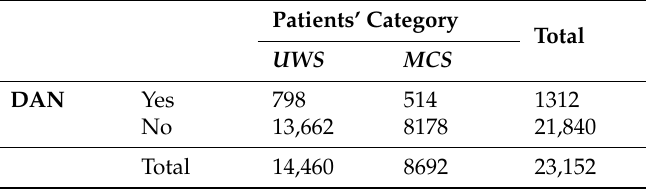
Table 7. Distribution of activation peaks within the dorsal-attentional network. The number of peaks is indicated for each patients’ category either within or outside the dorsal-attentional network. The total number of voxels represents the volume extent of the UWS and MCS conjunction map. These voxels are classified according to the intersection with the dorsal attentional network uniformity map. Under the table: the chi-squared test on the distribution of the activation peaks. UWS = unresponsive wakefulness syndrome; MCS = minimally conscious state; DAN = dorsal-attentional